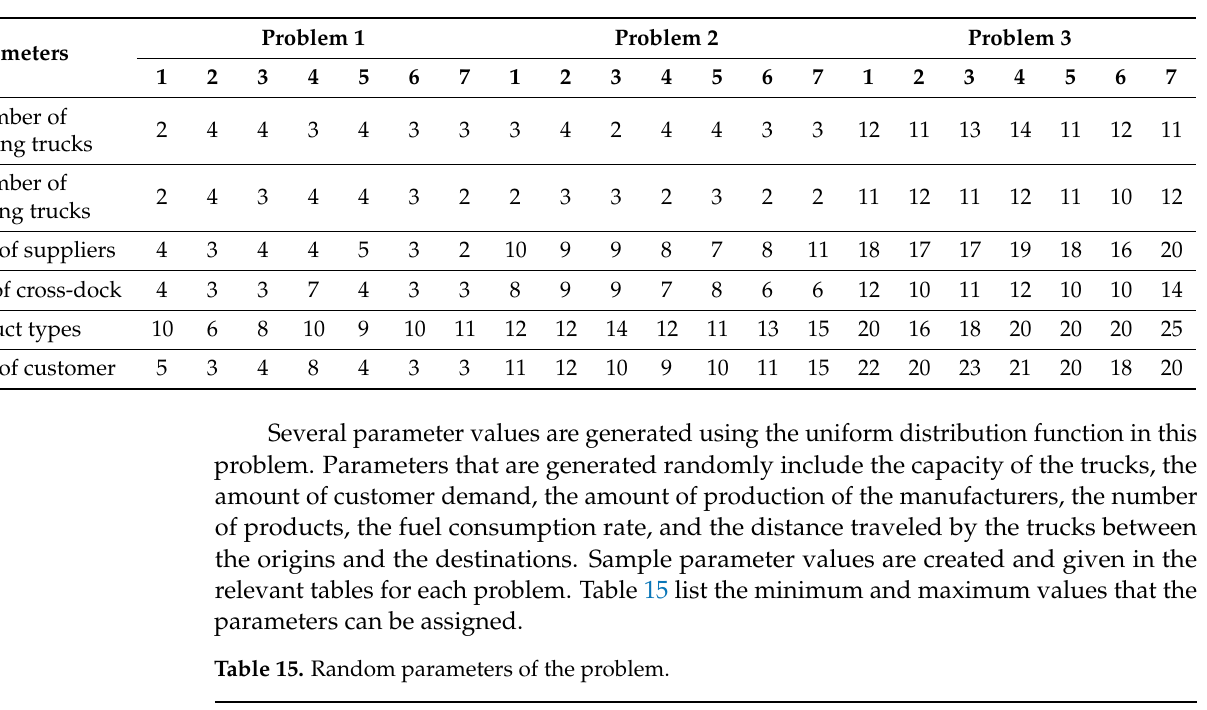
Table 14. Fixed parameters of the problems.